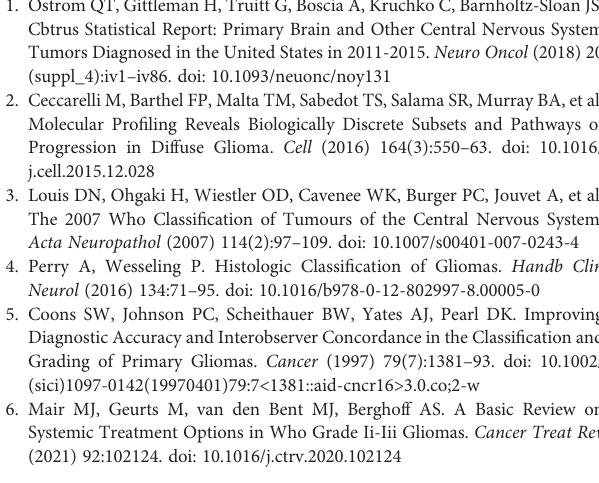
Supplementary Figure S1 | Survival analysis of cases in TCGA training cohort strati fi ed by gender, WHO grades and Radiotherapy. Kaplan-Meier curves of OS in (A) male, (B) female, (C) G2, (D) G3, (E) with or (F) without radiotherapy patients based on risk score in low grade glioma population. Supplementary Figure S2 | Survival analysis of cases in TCGA validation cohort strati fi ed by gender, WHO grades and Radiotherapy. Kaplan-Meier curves of OS in (A) male, (B) female, (C) G2, (D) G3, (E) with or (F) without radiotherapy patients based on risk score in low grade glioma population. Supplementary Figure S3 | Validation the prognostic performance of patients carrying wild ‐ type IDH1 genes, 1p19q codeletion or MGMT methylation. (A) IDH1 wild-type (WT) and mutation (Mutant) proportions in High Risk or Low Risk. (B) Chromosome1p19qcodeletion ornot(Non)proportions indifferentriskgroups. (C) MGMT methylation or not proportions in different risk groups. Kaplan-Meier curves of OS in IDH1 WT (D) , IDH1 mutant (E) , 1p19q codeletion (F) , 1p19q non- codeletion (G) , MGMT methylation (H) and MGMT unmethylation (I) based on risk score. Supplementary Figure S4 | Construction of weighted risk strati fi cation gene co- expression network and functional enrichment analysis. (A) The scale-free fi t index for soft thresholding powers. (B) Selecting the soft threshold of 4, checking the node connection number, and verifying the network connectivity of a scale-free network. (C) The correlation between network modules. Supplementary Figure S5 | Functional enrichment analysis of co-expression networks which containing risk strati fi cation genes. The co-expression module of weighted gene and the Gene Ontology Analysis of all the module gene within (A) MLLT3, FAM66C, (B) SEL1L3, SOX13, (C) EFHB colored by speci fi c cluster ID. Supplementary Figure S6 | Correlation between marker genes and risk grading genes. Marker genes related to (A) extracellular matrix remodeling, (B) immune response, (C) cytokine, and (D) chemokine release were selected from MsigDB database, and the correlation between the above marker genes and risk grading genes was analyzed in TCGA-LGG data